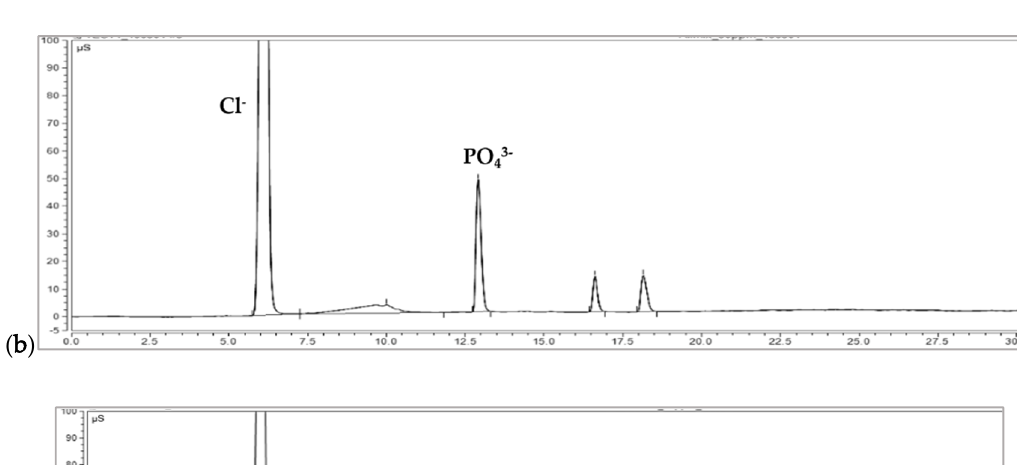
− − − , P 2 O 74 , and P 3 O 105 as